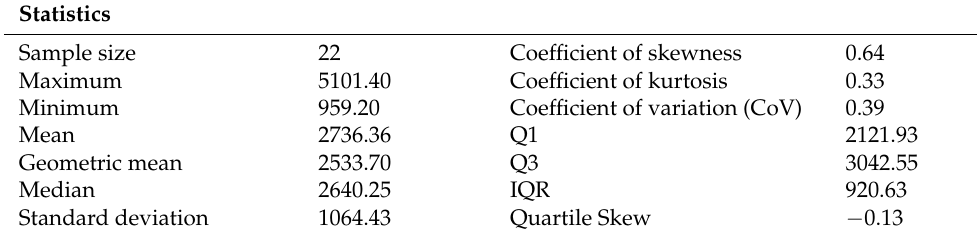
Table 5. Sample statistics for the annual maxima series (m 3 /s) of synthetic peak